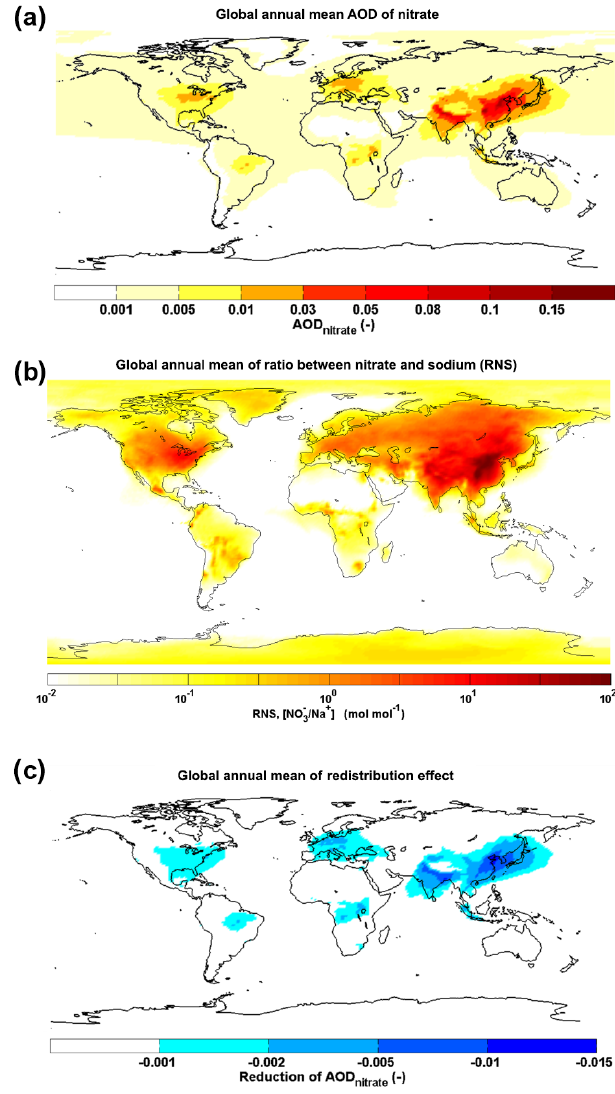
Figure 10. The global distribution of annual mean AOD nitrate (a) , RNS (b) and reduction in AOD nitrate associated with the redistri- bution effect (c) . The results of (a) and (b) are simulated with the EMAC model; the results of (c) are estimated from the first-order approximation in Fig.